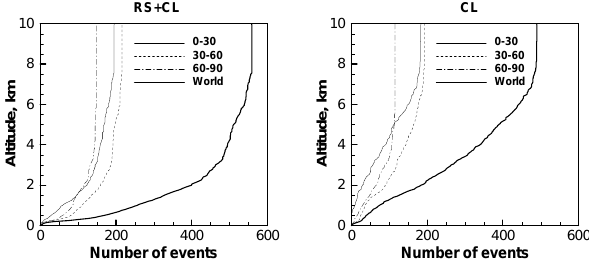
Fig. 8. Penetration depth for RO events observed on 30 Septem- ber 2007 and processed in the RS+CL (left panel) and CL (right Figure 8. Penetration depth for RO events observed on September 30, 2007 and processed in 3 panel) merging modes: the whole globe (“World”), tropics (“0– the RS+CL (left panel) and CL (right panel) merging modes: the whole globe (‘World’), 4 30”), mid-latitudes (“30–60”), and polar latitudes tropics (‘0–30’), mid-latitudes (‘30–60’), and polar latitudes (‘60–90’). 5